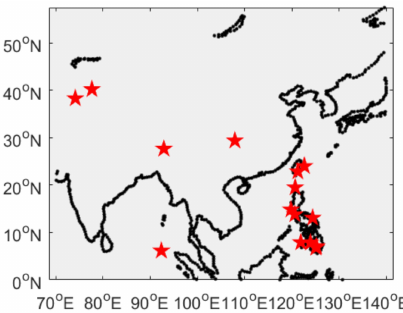
Figure 19. Epicentres of earthquakes following four-channel